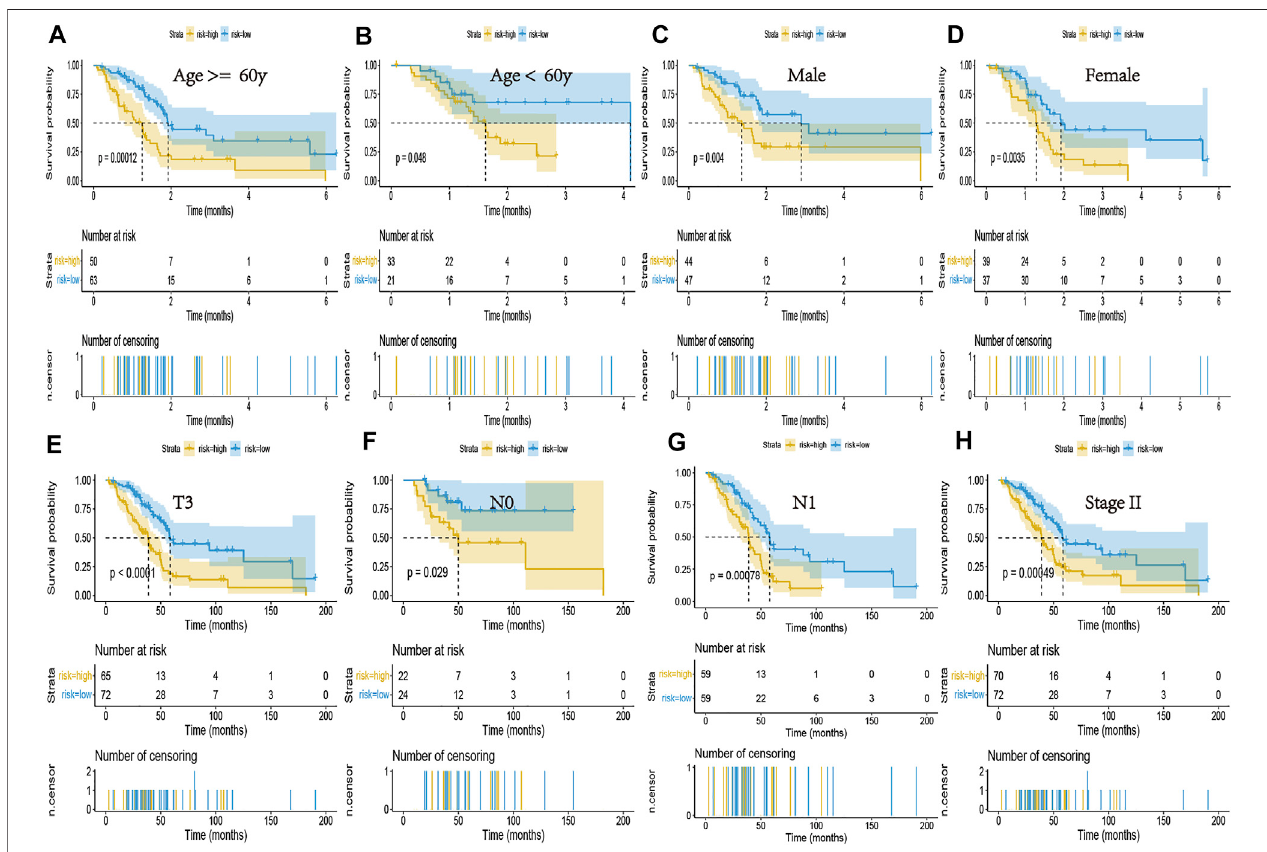
FIGURE5| Kaplan-Meier curves oftheNRGsignature inpatientsstrati fi edby age,gender, and tumor stage. (A,B) Differences in OSbetween patients in thehigh- and low-risk groups, strati fi ed by age. (C,D) Differences in OS between patients in the high- and low-risk groups, strati fi ed by gender. (E) Difference in OS between patients in the high- and low-risk groups, strati fi ed by T3 stage. (F,G) Difference in OS between patients in the high- and low-risk groups, strati fi ed by N stage. (H) Difference in OS between patients in the high- and low-risk groups, strati fi ed by Stage II.